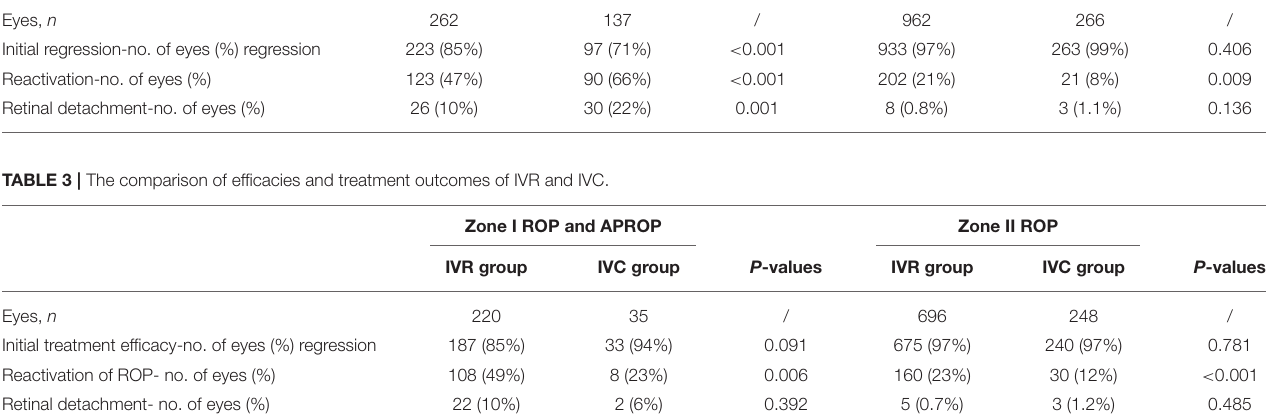
Retinal detachment- no. of eyes